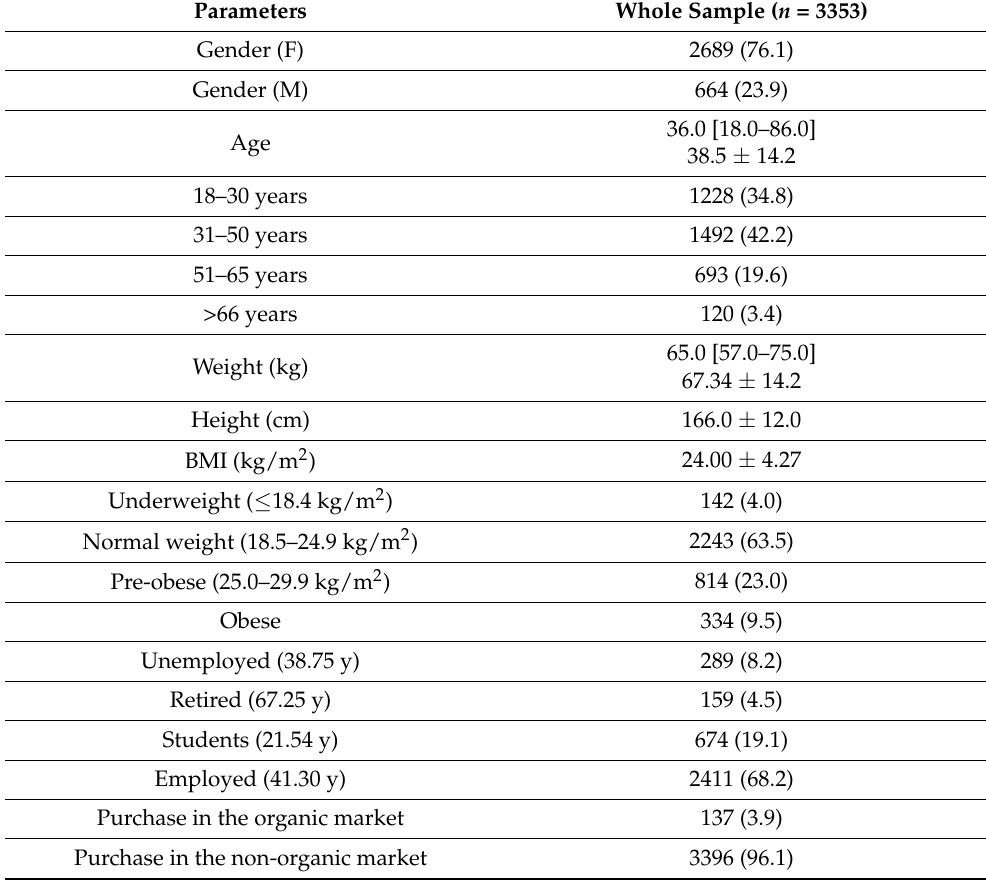
Table 1. General characteristics of the whole sample. Values are expressed as means and standard deviations (M ± SD) for continuous variables. Abbreviations: body mass index